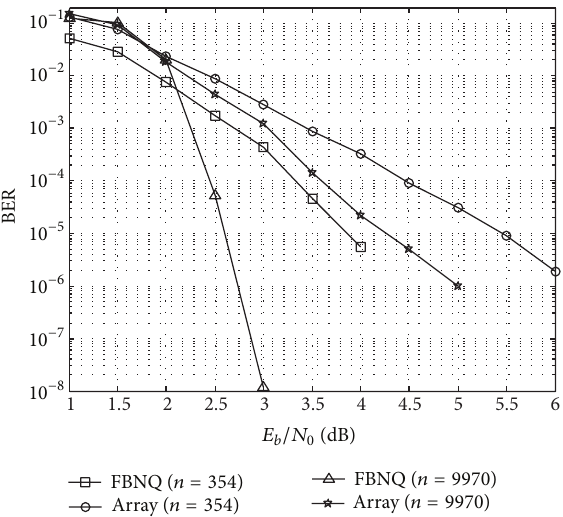
Figure 2: The curves of Fibonacci-constructed QC-LDPC and QC- LDPC codes BER (bit error rate) constructed by array